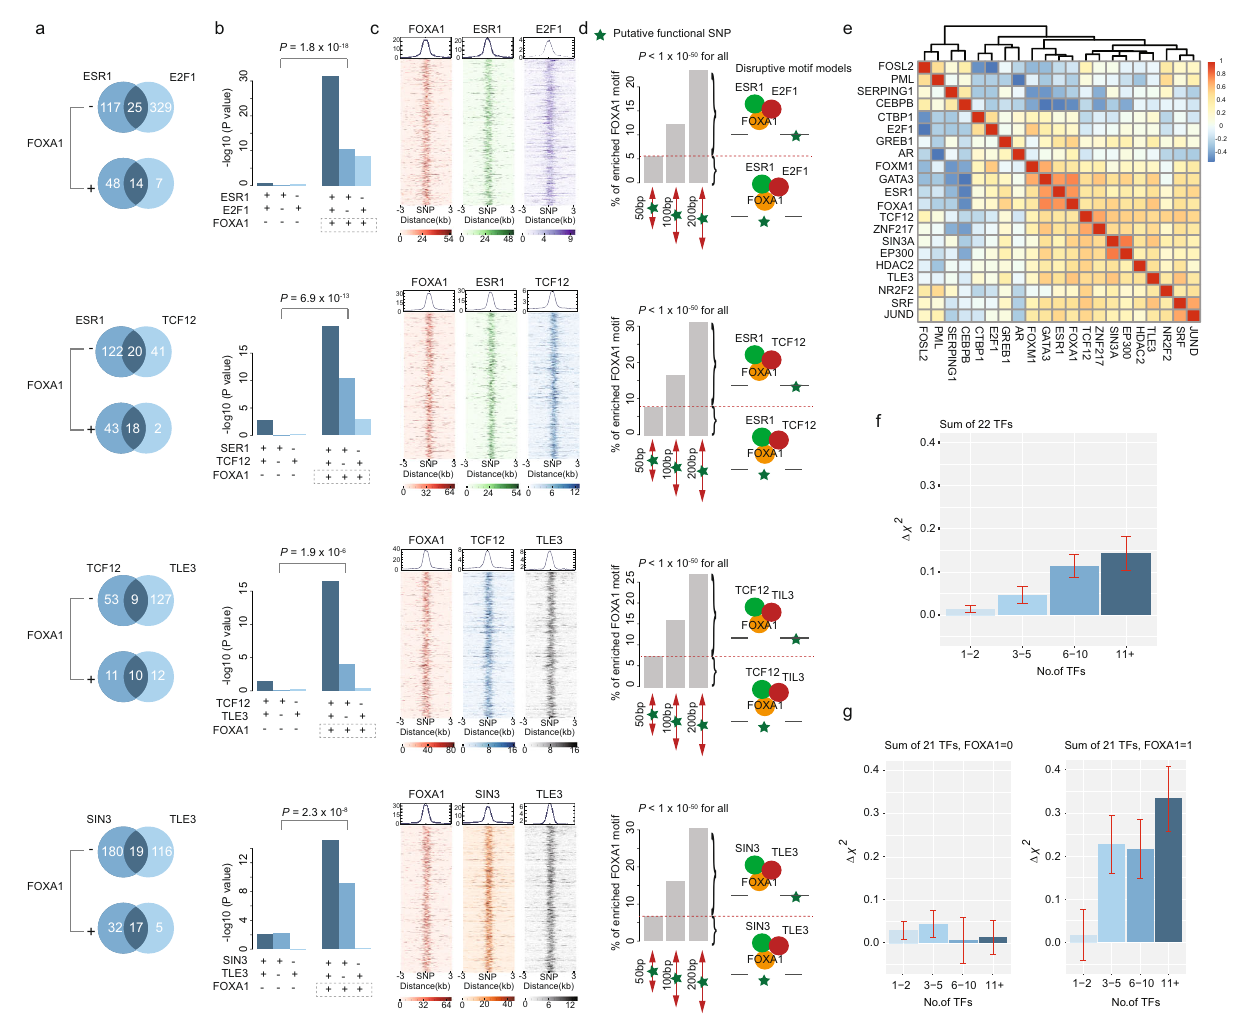
Fig. 3 FOXA1 interacting with co-factors, driving breast cancer susceptibility. a The numbers of genetic variants (multiplied by 1000) that are occupied by speci fi c TFs or co-occupied by two TFs, strati fi ed by FOXA1. b Barplots show the association strengths for genetic variants occupied by speci fi c TFs occupancy. The “ + ” and “ − ” symbols underneath the x axis represents genetic variants with and without occupancy of speci fi c TFs. P -value on the top shows the signi fi cance of the interaction between FOXA1 and TF pairs. c Heatmap shows the TF binding signals for the fl anking regions of genetic variants co-occupied by FOXA1 and TF pairs. The heavy color in each panel denotes the binding signal of the TF of interest. d Barplots show the proportion of the detected FOXA1 motif based on motif enrichment analysis for fl anking regions of genetic variants (i.e., ±25, 50, and 100bp). Disruptive motif models are illustrated in the right panel. e Heatmap shows a correlation pattern based on gene-expression data of 22 TFs in the GTEx data. The color change from blue to red denotes the correlation coef fi cients changes from − 0.5 to 1. f Barplots show association (regression coef fi cients) of TF score with breast cancer risk in BCAC data. g Barplots show an association of TF score with breast cancer risk in BCAC data, strati fi ed by FOXA1. In these fi gures, the two-sided nominal P -values and 4 χ 2 were derived from the generalized mixed models and the error bars denote 95% con fi dence essentiality on cell proliferation, at P < 6.2 × 10 − 4 , a Bonferroni-